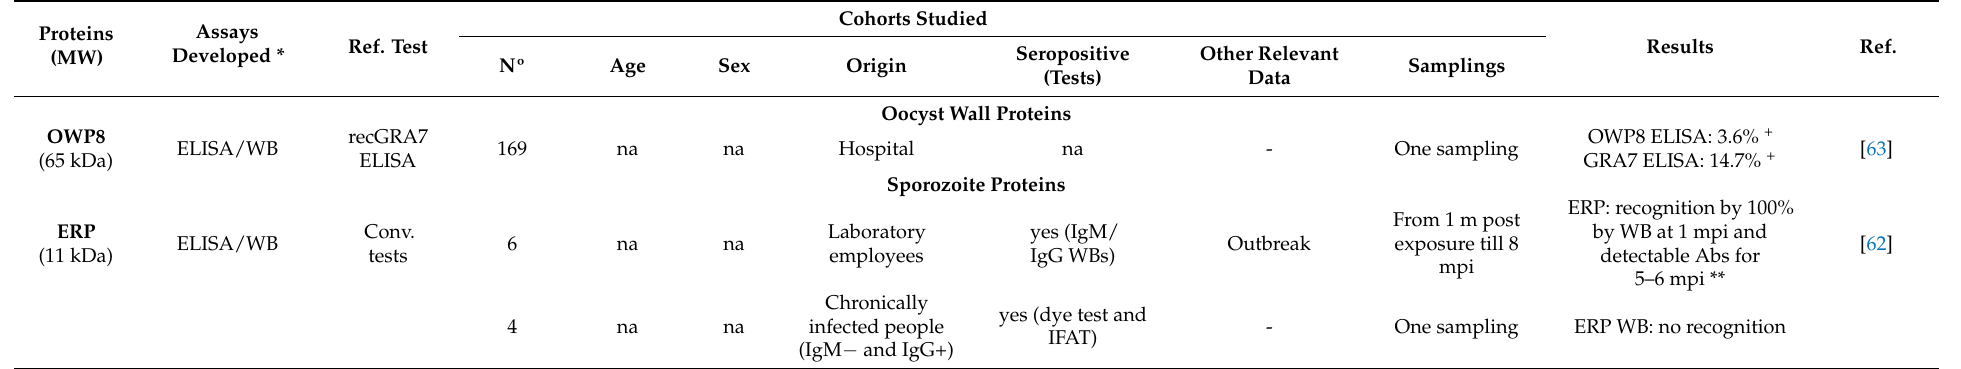
Table 2. Oocyst recombinant protein-based serological tests developed to differentiate oocyst-driven infections from tissue cyst-driven infections in